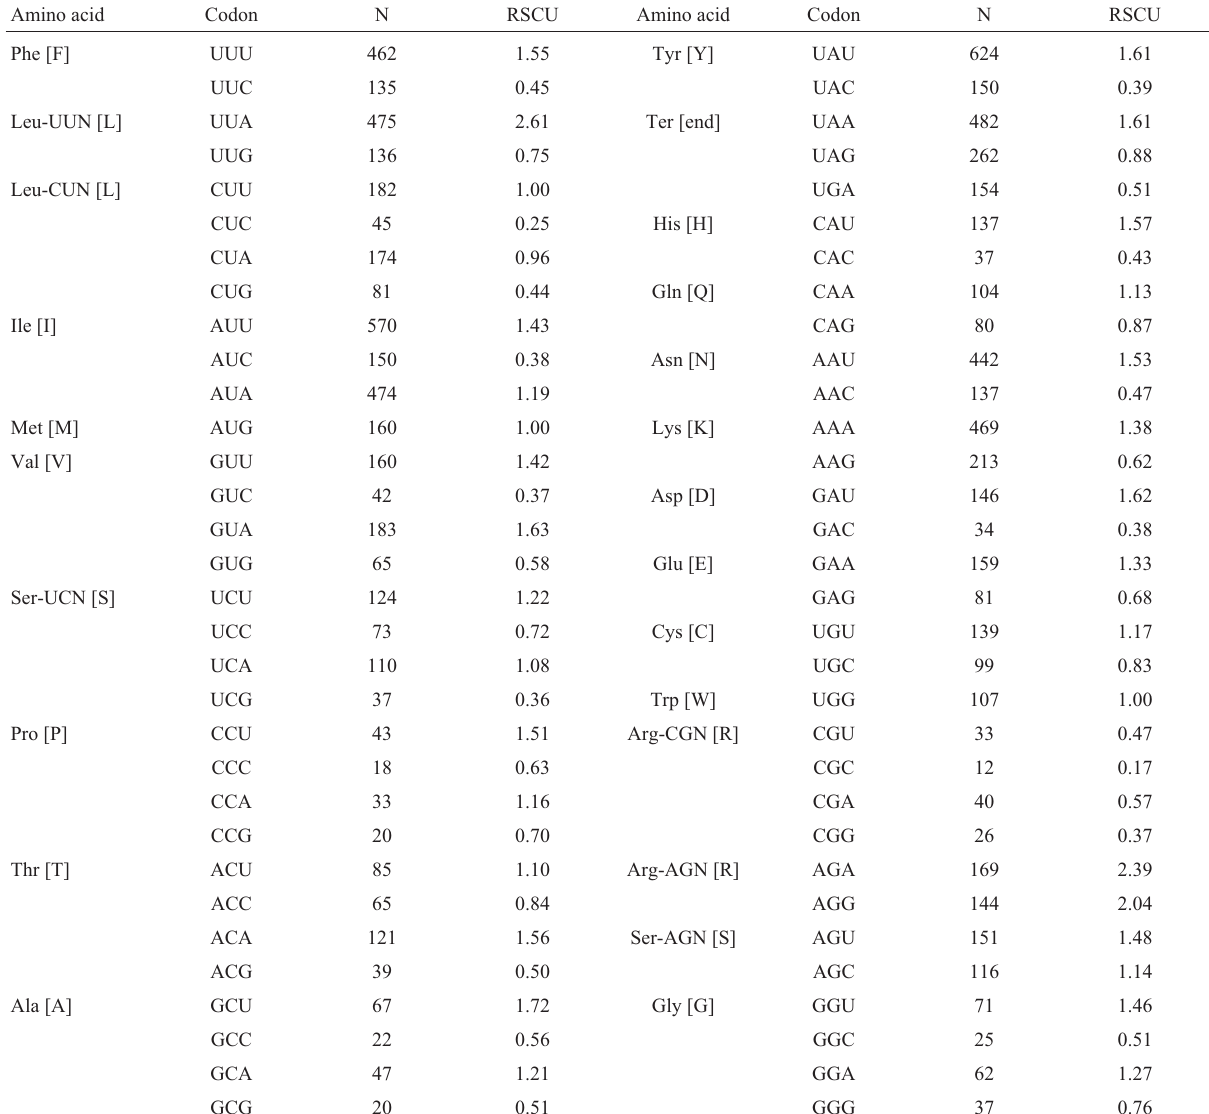
Table 2 - Number of codons and codon usages in mt protein-coding genes of E. album. Amino